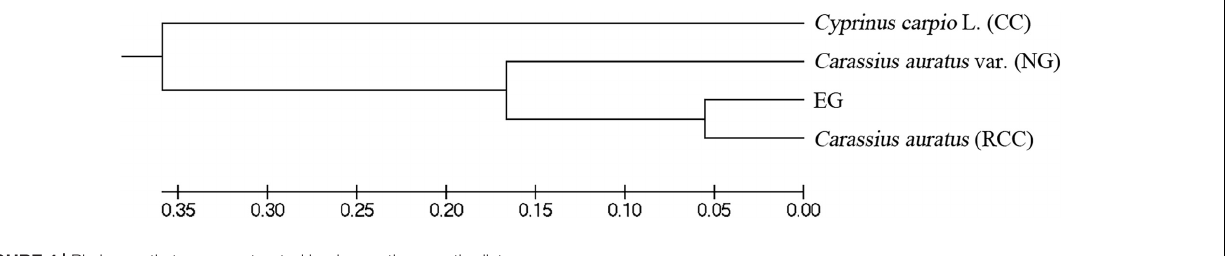
FIGURE 4 | Phylogenetic trees constructed basing on the genetic